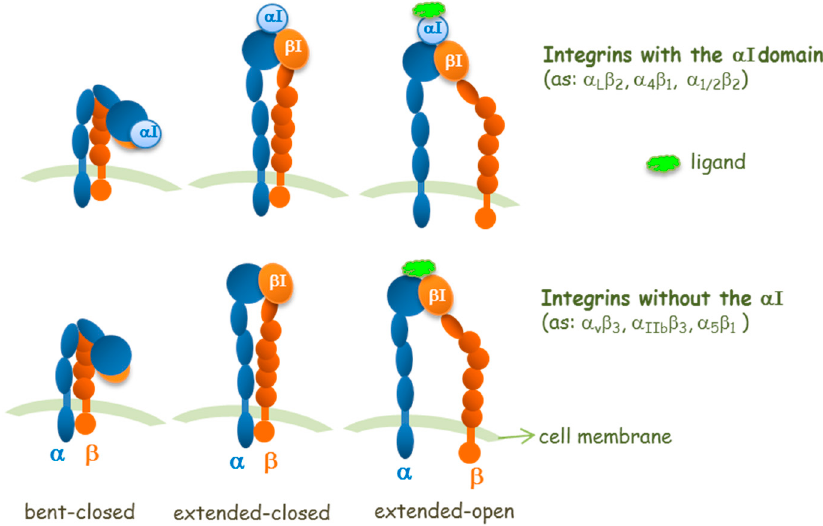
Figure 2. Schemes for three conformational states of α I-integrins and integrins without the α I domain, and interaction sites of a ligand.